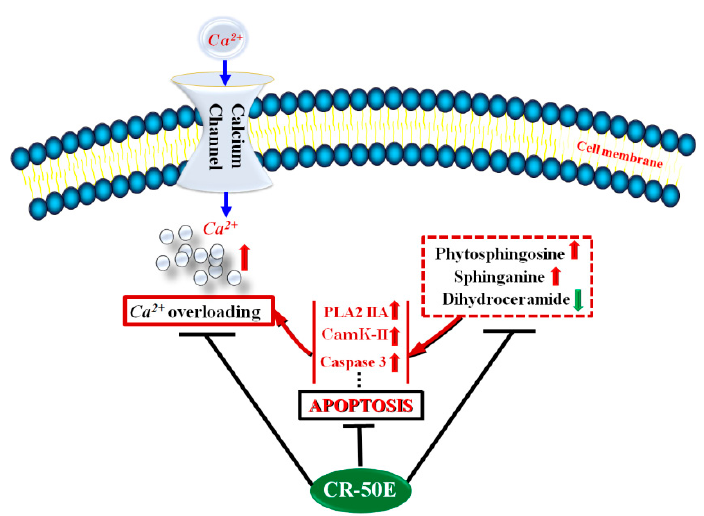
Figure 5. The schematic representation of the neuroprotective effect of CR-50E .